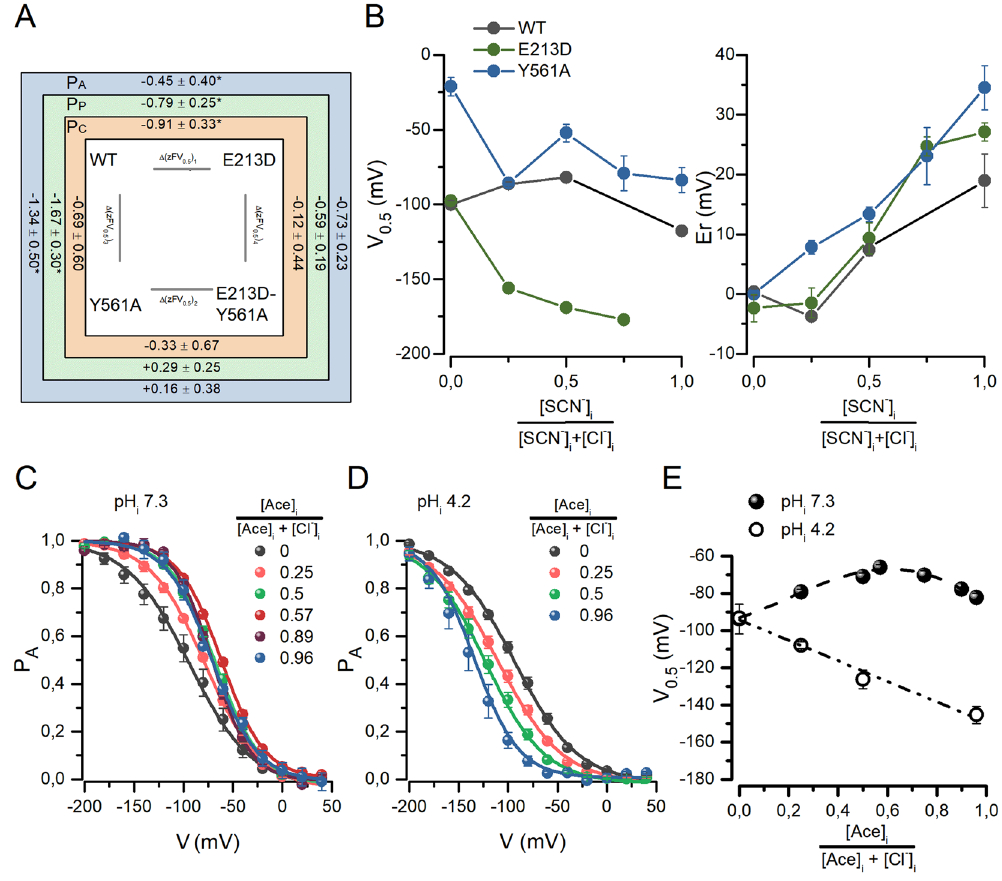
Figure 4. Double mutant cycle analysis and anomalous mole fraction behaviour show coupling of E213 and Y561. (A) Double mutant cycle analysis. The analysis was performed using the z and V 0.5 obtained for P A (blue square), P P (green square), and P C (orange square) for the WT, E213D, Y56A and E213D-Y561A channels listed in Table 1. Δ(zFV 0.5 ) 1 , Δ(zFV 0.5 ) 2 , Δ(zFV 0.5 ) 3 , and Δ(zFV 0.5 ) 4 are the energy change in the voltage-dependent gating caused by a given mutation calculated using Eq. (1). For example, Δ(zFV 0.5 ) 1 is the energy change induced by mutating E213 in the WT CLC-2. The listed energy change values are in kCal/mol. The asterisks indicate statistically significant different pair Δ(zFV 0.5 ) 1 :Δ(zFV 0.5 ) 2 and Δ(zFV 0.5 ) 3 :Δ(zFV 0.5 ) 4 values. (B) Anomalous mole fraction behaviour of the voltage-dependent activation and reversal potential of WT (n = 5–9), E213D (n = 6–10), and Y561A (n = 4–7) channels. AMF behaviour was evaluated using SCN − /Cl − mixtures. V 0.5 values V 0.5 . (C,D) Voltage-dependent activation determined at pHi of 7.3 (n = 5–10) and 4.2 (n = 5–7) using different acetate mole fractions.